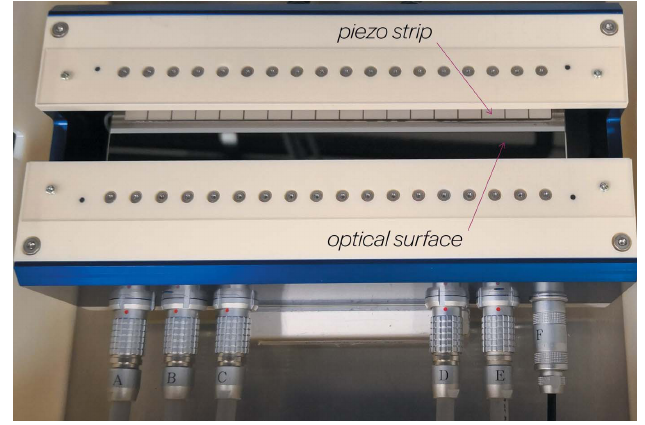
Figure 6 Piezo-bimorph deformable X-ray mirror. The adaptive X-ray mirror (JTEC Corporation) that was studied and characterized in our experiments. A segmented piezo strip enables spatially localized deformations of the optical